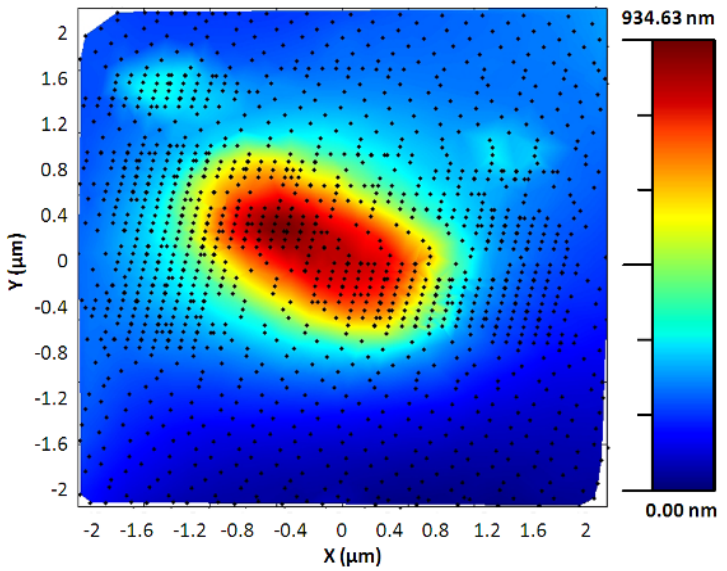
Figure 8. Image acquired with the bang-bang controller of an Escherichia coli